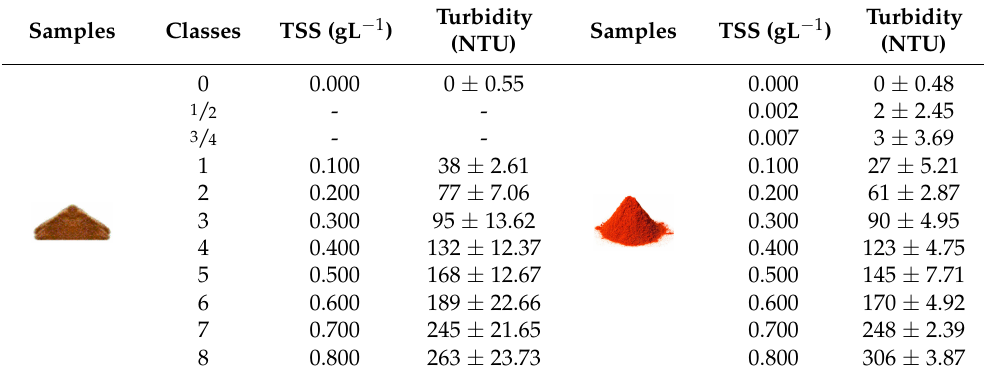
Table 6. Turbidity samples of the reference measured with the HACH DR900 for each TSS of the fish feed and paprika samples. Turbidity samples are shown as mean data ± standard deviation.